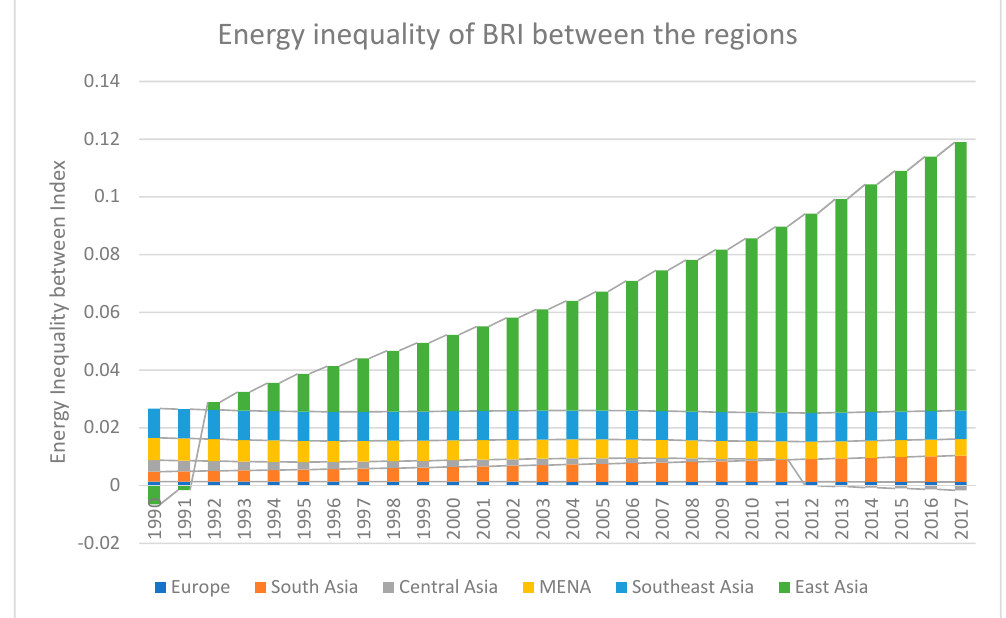
Figure 5. Energy Inequality of BRI between the regions. Energies 2019 , 12 , x FOR PEER REVIEW